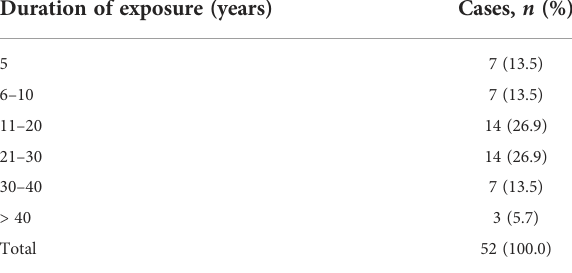
TABLE 2 Duration of exposure among the